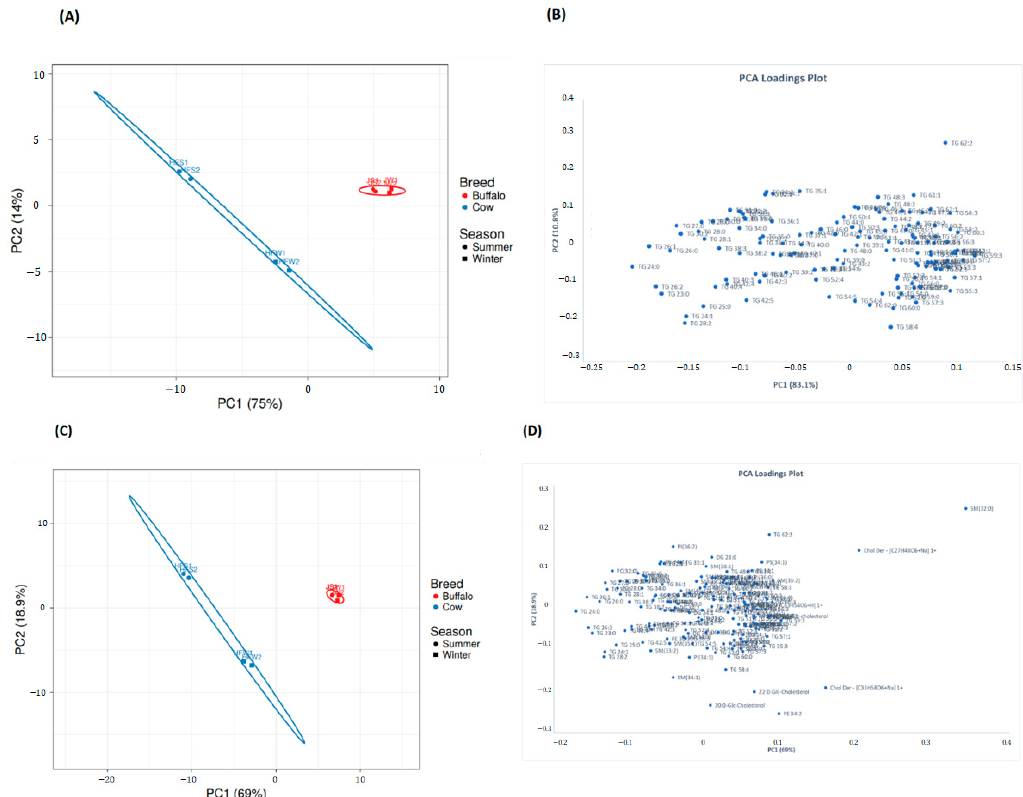
Figure 5. PCA scores and loadings plots. ( A ) Scores plot and ( B ) loadings plot from the PCA of the 141 TG species. ( C ) Scores plot and ( D ) loadings plot from the PCA of the 193 lipid species. The scores plot in ( A ) exhibits a wider separation between the JS and JW samples in the PC1-axis than in ( B ). Each dot / square is the average of 15 cows / bu ff alos. For each breed / season, samples were collected twice in the 1st lactation period between ( A ) 30–40 days for JS, ( B ) 50–60 days for JW, ( C ) 30–40 days for HFS, and ( D ) 50–60 days for HFW.